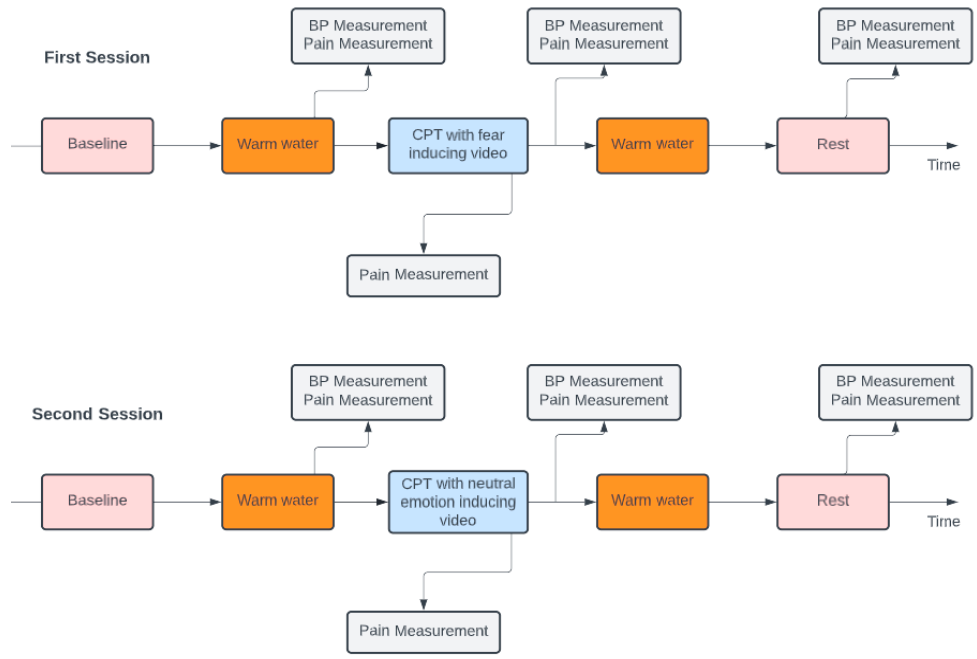
Figure 2. Scheme of the implemented protocol.